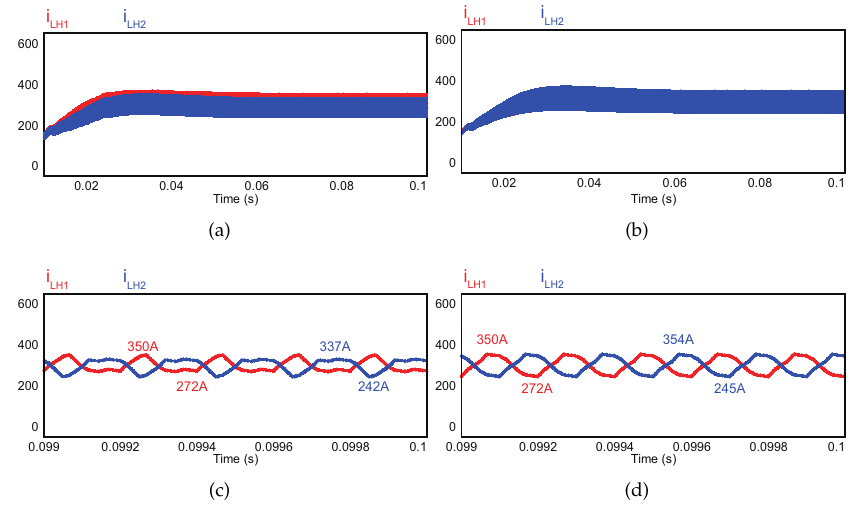
Figure 20. ( a ) Inductor currents for Z-type interleaving with two current controller ( b ) inductor currents for N-type interleaving with two current controller ( c ) Enlarged (a); ( d ) Enlarged (b). However, the different current response may be appeared when only one current controller is used. Figure 21 shows the current waveform for two-phase TLBC with single current controller for both interleaving methods. For the Z-type interleaving method, as illustrated in Figure 21, the inductor current is concentrated in one module, similar to the case of open loop drive. However, with the N-type interleaving method, the inductor currents are evenly distributed in each module.